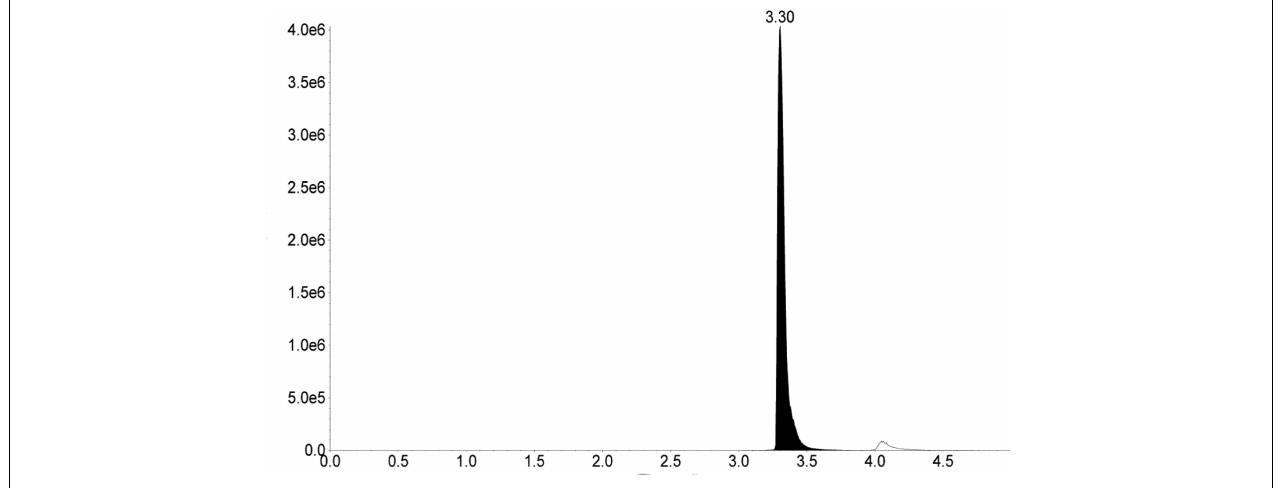
FIGURE 1 | MRM chromatogram of melittin (m/z 712.8– > 70.0) in the bee venom